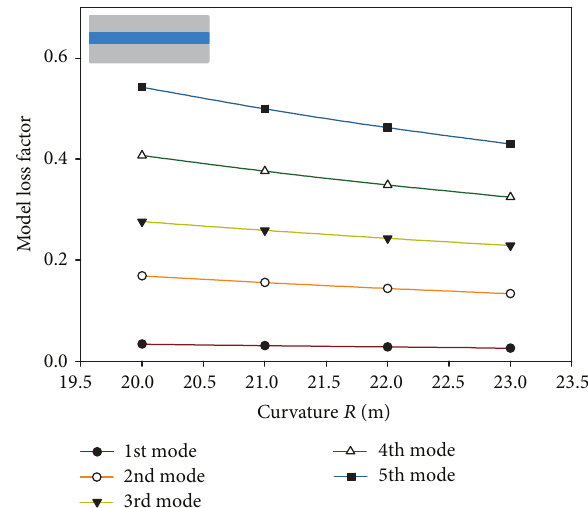
Figure 5: Variation of modal loss factor of cylindrical aluminum panel in case of SSDL with variation of curvature 𝑅 ( 𝑎 = 0.2 m, 𝑏 = = 5 mm, 𝑡 = 2 mm, 𝑡 = 5 mm, and 𝜂 = 0.1 ). 0.1 m, 𝑡 1 2 3